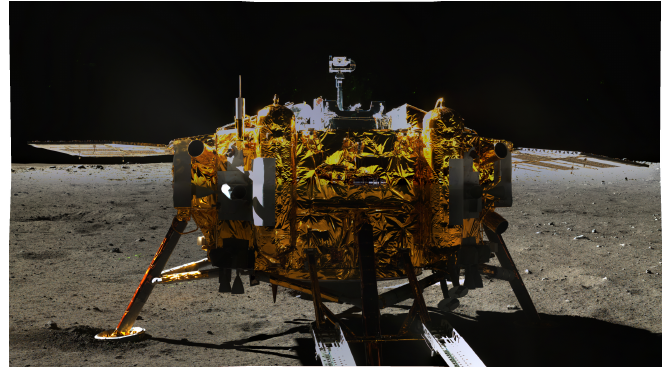
Figure 10. Lander panoramic mosaic image. Table 4. MSE (Mean Square Error) and PSNR (Peak Signal to Noise Ratio) results of Red-Green-Blue channel in experiments shown in Figure